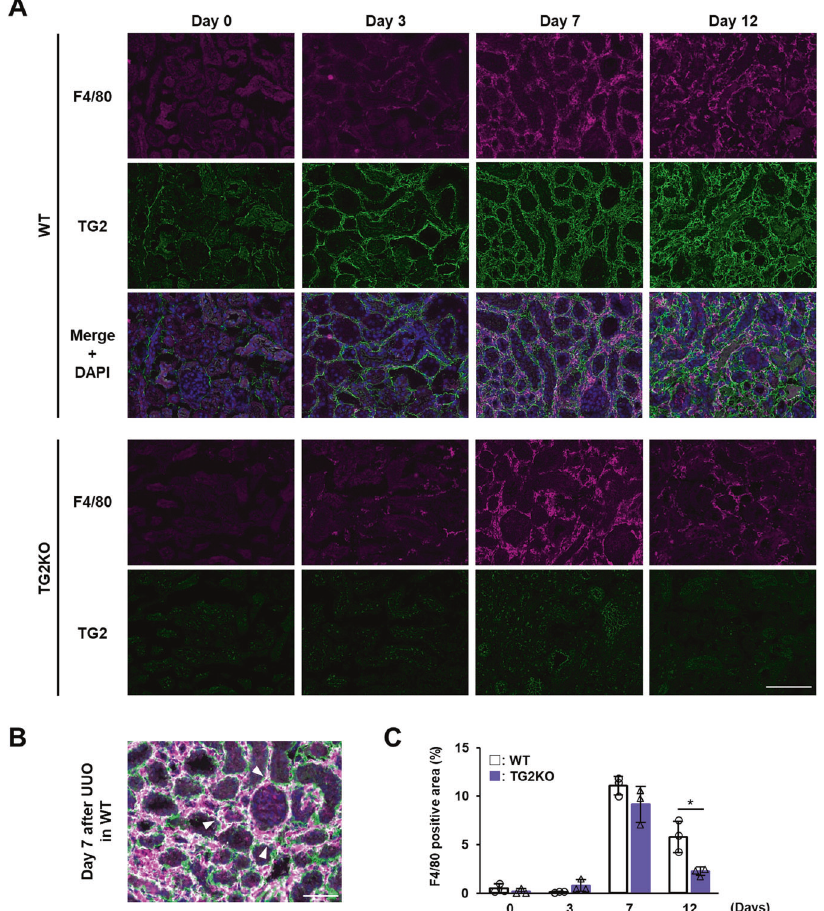
Fig. 1 Evaluation of macrophage in fi ltration into the kidney after UUO surgery in TG2KO mice. Mice were conducted to UUO surgery. Kidney sections from WT and TG2KO mice after UUO surgery were fi xed in 4% paraformaldehyde and immunostained using anti-F4/80 plus Alexa Fluor 594 anti-rat antibodies and anti-TG2 plus Alexa Fluor 488 anti-rabbit antibodies ( A ). The nuclei were counterstained with DAPI. Scale bar = 100 μ m. The merged image from WT on day 7 after UUO was enlarged ( B ). Arrowheads indicate the similar distributions between F4/80 and TG2. Scale bar = 50 μ m. The percentages of F4/80-positive area are presented ( C ). Data are presented as the mean ± SD ( n = 3) (* P < 0.05, Student ’ s t